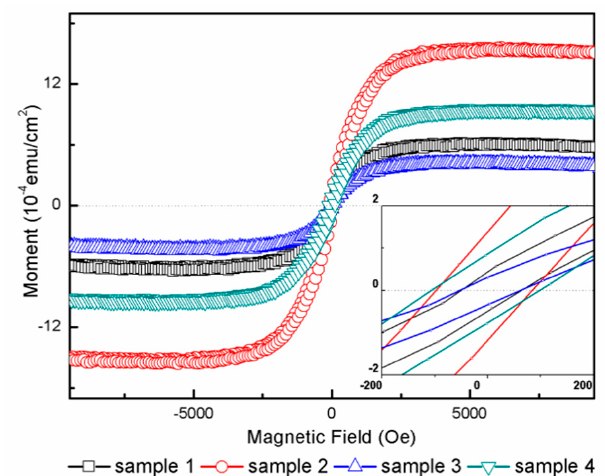
Figure 4. Magnetic field vs. moment curve of samples 1–4 measured at room temperature. The insert shows a zoomed-in view of the small field.